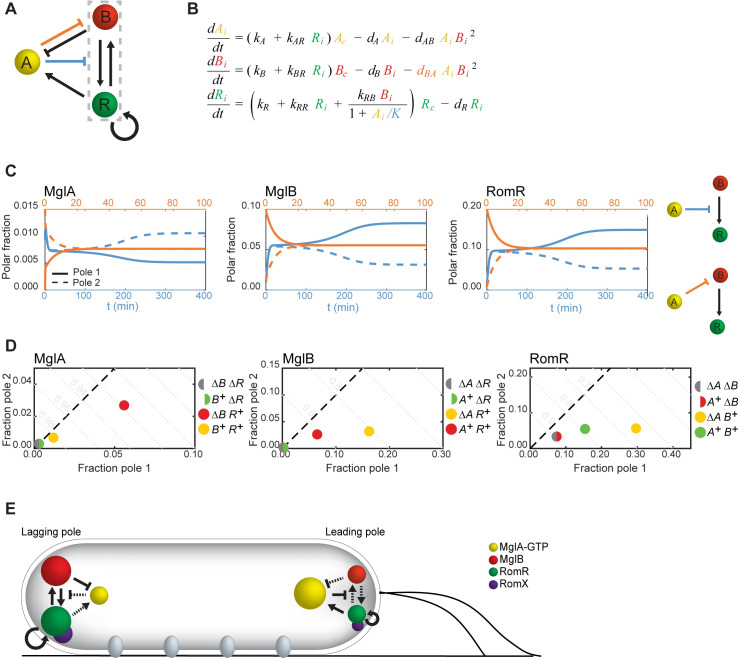
Mathematical model of the polarity module.A. Summary of the interactions inferred from experiments in Figs 4 and 5. Dashed box highlights the positive feedback between MglB and RomR. Blue and orange indicate possible modes of actions of MglA on polar localization of MglB and RomR. B. Equations of the mathematical model. Model variables Xi represent the fraction of species X localized at pole i = 1 or 2, and Xc = 1-X1-X2 is the non-polar fraction. Ai, Bi, Ri represent the fraction of MglA, MglB and RomR/RomX, respectively, localized at pole i (where i = 1 or 2). The corresponding non-polar fractions are represented by Ac, Bc, and Rc, where Xc = 1+X1-X2. C. Dynamics of mathematical model with different modes of action for MglA (indicated by colors in the corresponding network diagrams to the right). Solid and dashed lines indicate the polar fractions of each protein at the two poles. Pole 1 and pole 2 are defined by the localization of MglB and RomR. When MglA suppresses recruitment of RomR by MglB, polarity is established from a small initial asymmetry (X1(0) = 0.011, X2(0) = 0.01 for X = A,B,R). When MglA enhances MglB dissociation, asymmetry is lost and the cell becomes symmetric (Xi(0) set to the WT mean polar fractions in snapshot experiments, Figs 2A and 5A, but with MglA polarity inverted relative to MglB and RomR). Parameter values are given in S5 Table. D. Steady state polar fractions produced by the combined mathematical model with both modes of action for MglA, in WT, single- and double-mutant conditions. E. Different interactions dominate at the leading and lagging poles. Full arrows show locally strong interactions, dashed arrows show interactions that are locally suppressed. Amounts of each protein localized at each pole are indicated by the size of the corresponding cluster.